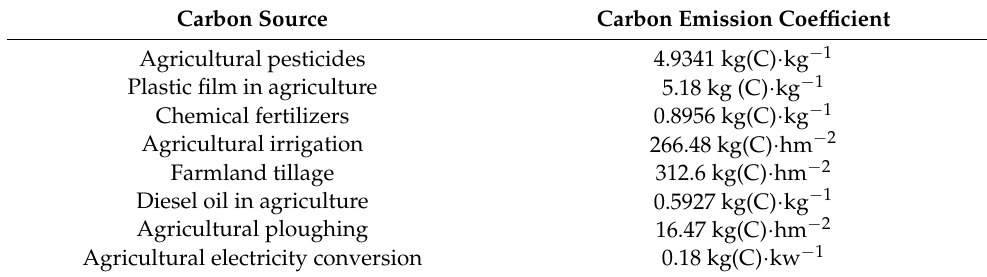
Table 2. Carbon emission